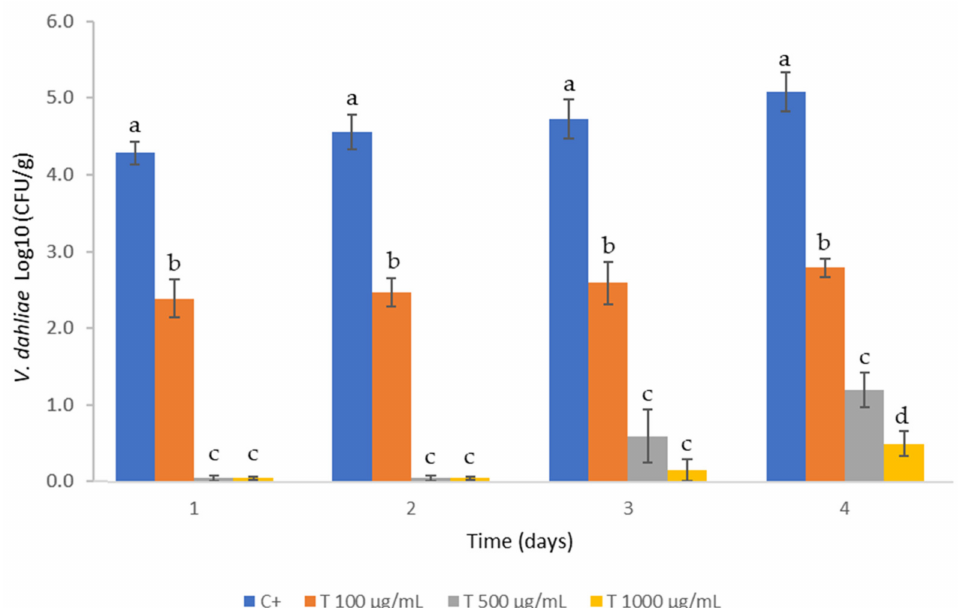
Figure 4. Concentration of Verticillium dahliae in soil after treatment with the blend of PTS and PTSO in 1:1 proportion at different concentrations (100, 500 and 1000 µ g/mL) compared to a positive control group (C +) that consists of sterilized soil inoculated with V. dahliae but without treatment. Values are means with standard deviation in bars. For each sampling day, bars with a different letter (a–d) indicate significant differences according to Tukey HSD test at p <